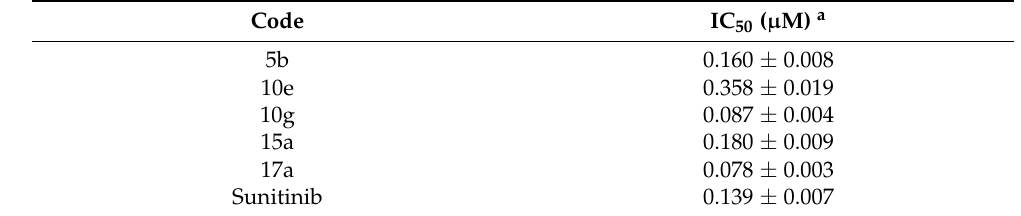
Table 2. In vitro VEGFR-2 kinase inhibitory activities of compounds 5b , 10e , 10g , 15a and 17a